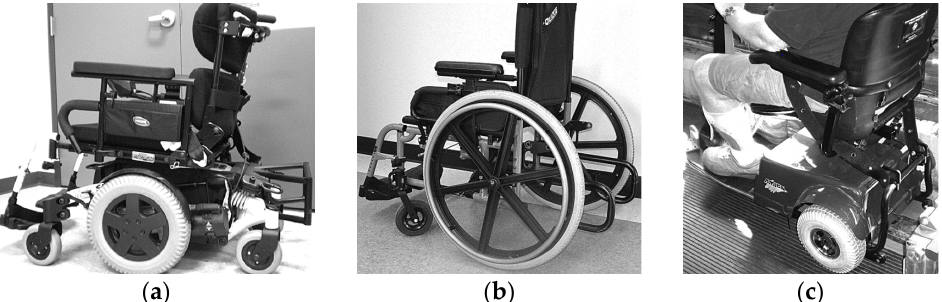
Figure 5. A power wheelchair ( a ), manual wheelchair ( b ), and scooter ( c ) equipped with UDIG ‐ compatible hardware.